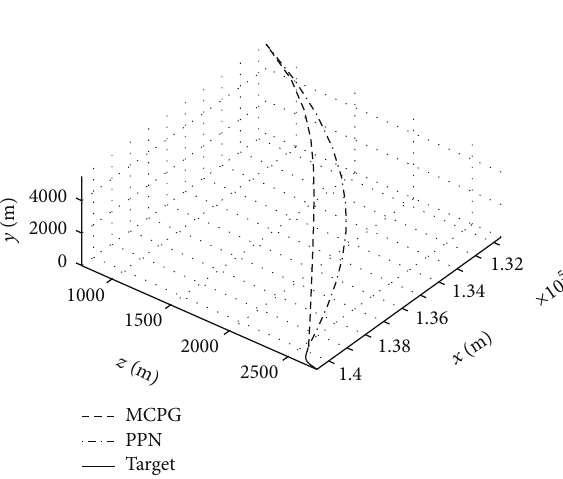
Figure 4: Longitudinal acceleration of different ratios.